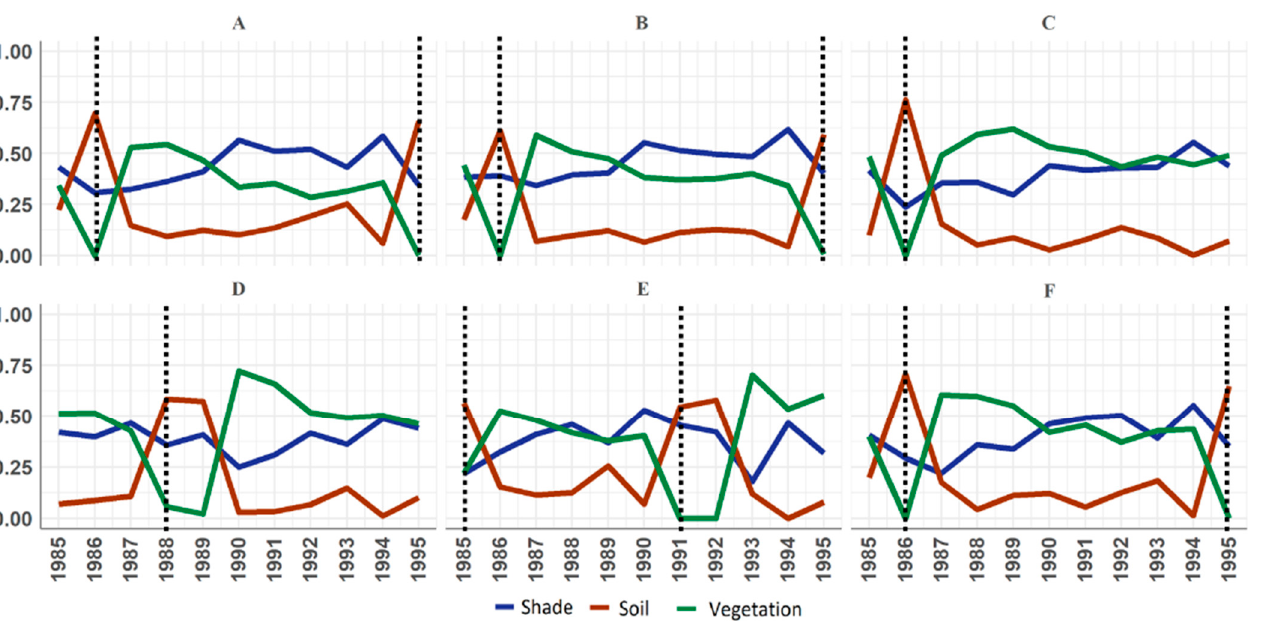
Figure 13. Phenological assessment of eucalypt plantation during the 1985–1995 period based on the fraction-image time series and forest plantation rotation for six samples ( A – F ), as shown in Figure 2.